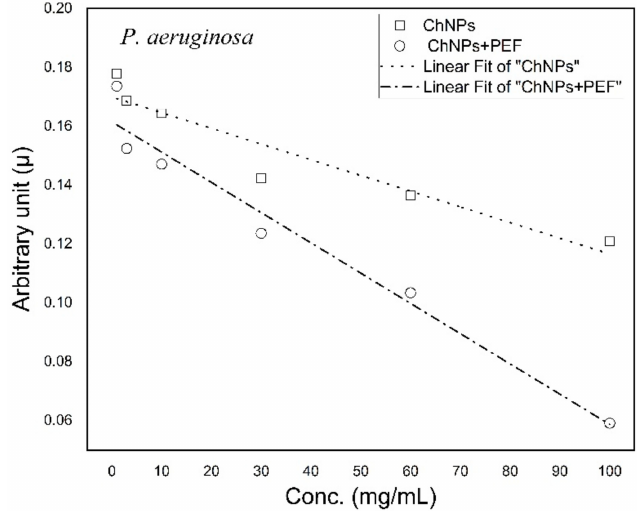
Figure 7. Trend lines of arbitrary constant values for P. aeruginosa treated by ChNPs alone and combined with PEF.